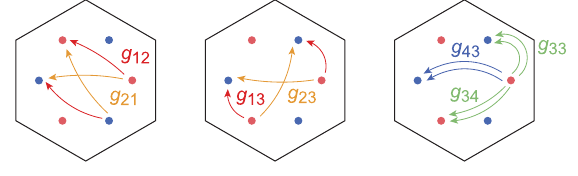
FIG. 12. Seven momentum-nonconserving scattering